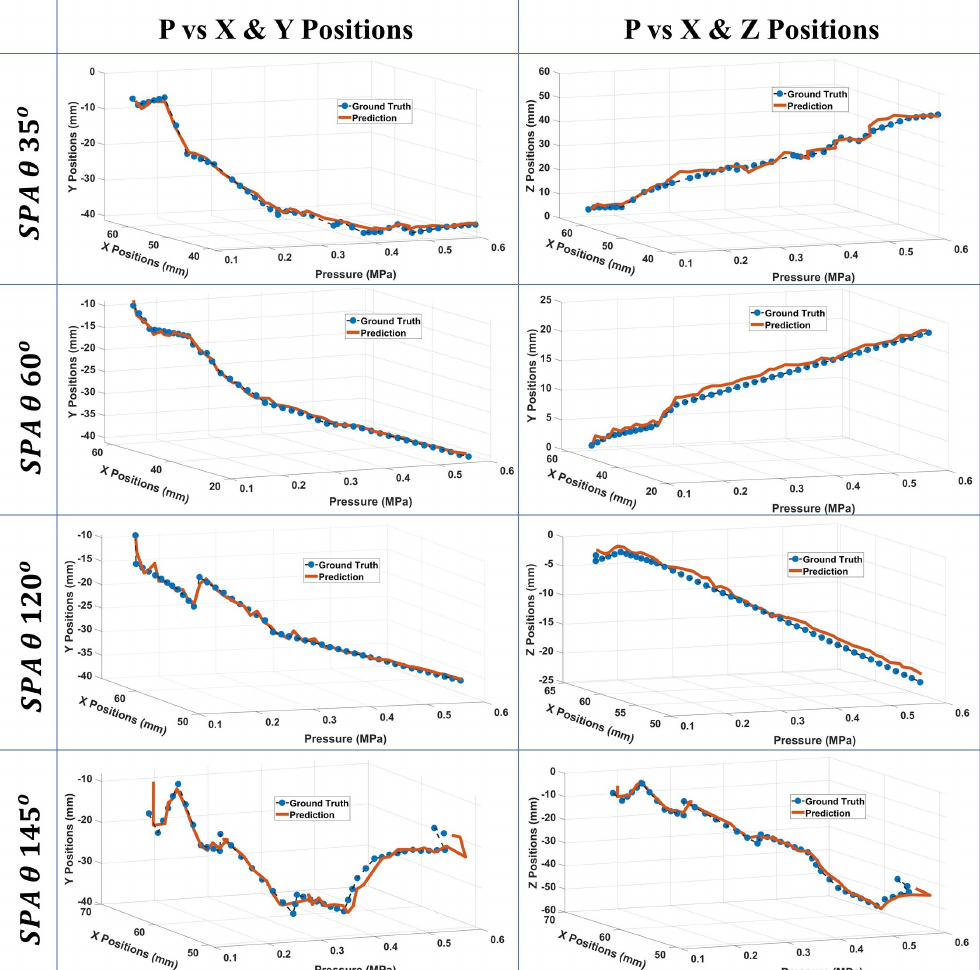
Figure 7. Prediction results of the LSTM network trained on the interpolated data. The plots are for 4 test